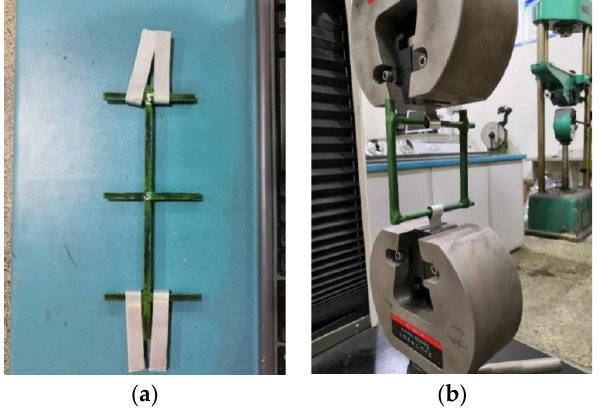
Figure 1. Sample of tensile test. ( a ) Single BFR; ( b ) BFR mesh. Table 1. Tensile strength of single BFR.